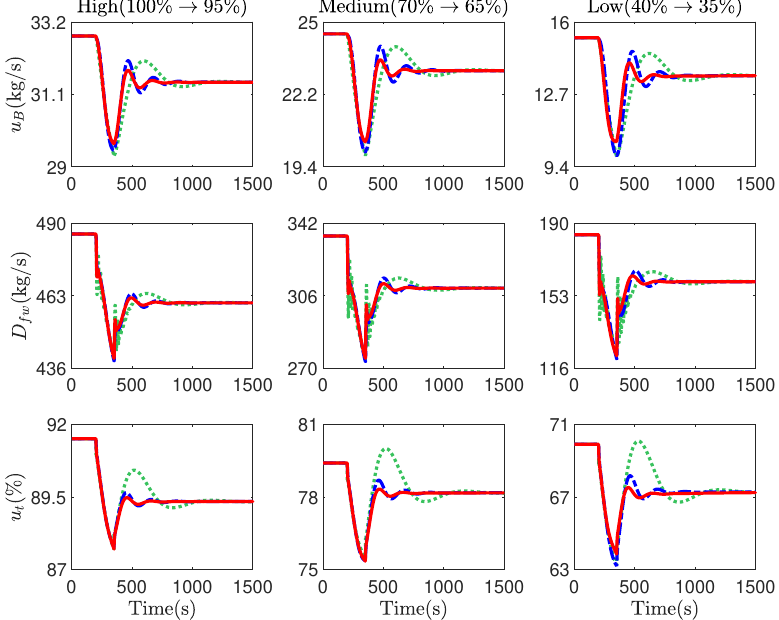
Figure 9. Load following performance of supercritical CFB unit at typical conditions (load